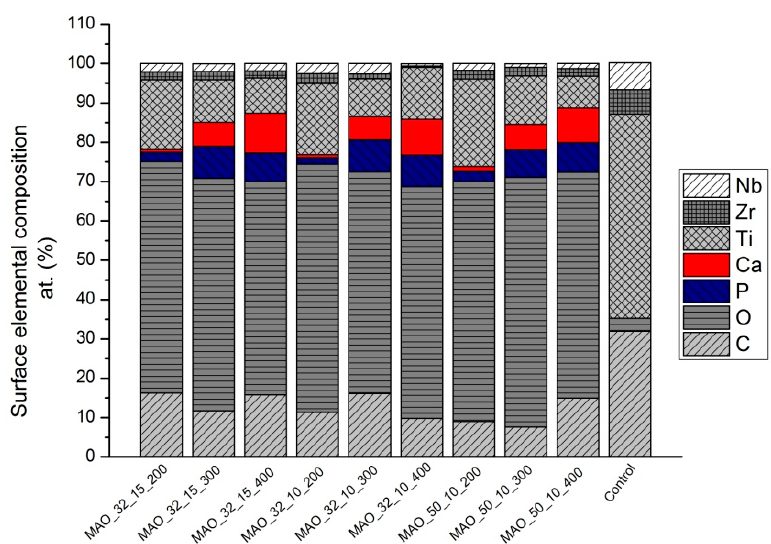
Figure 4. Surface elemental composition analysis (at.%) of the investigated control specimens and MAO coatings with various MAO process parameters measured by energy dispersive X-ray spectrometry EDS (the presented results are representative for three analyses of each surface treatment specimens).